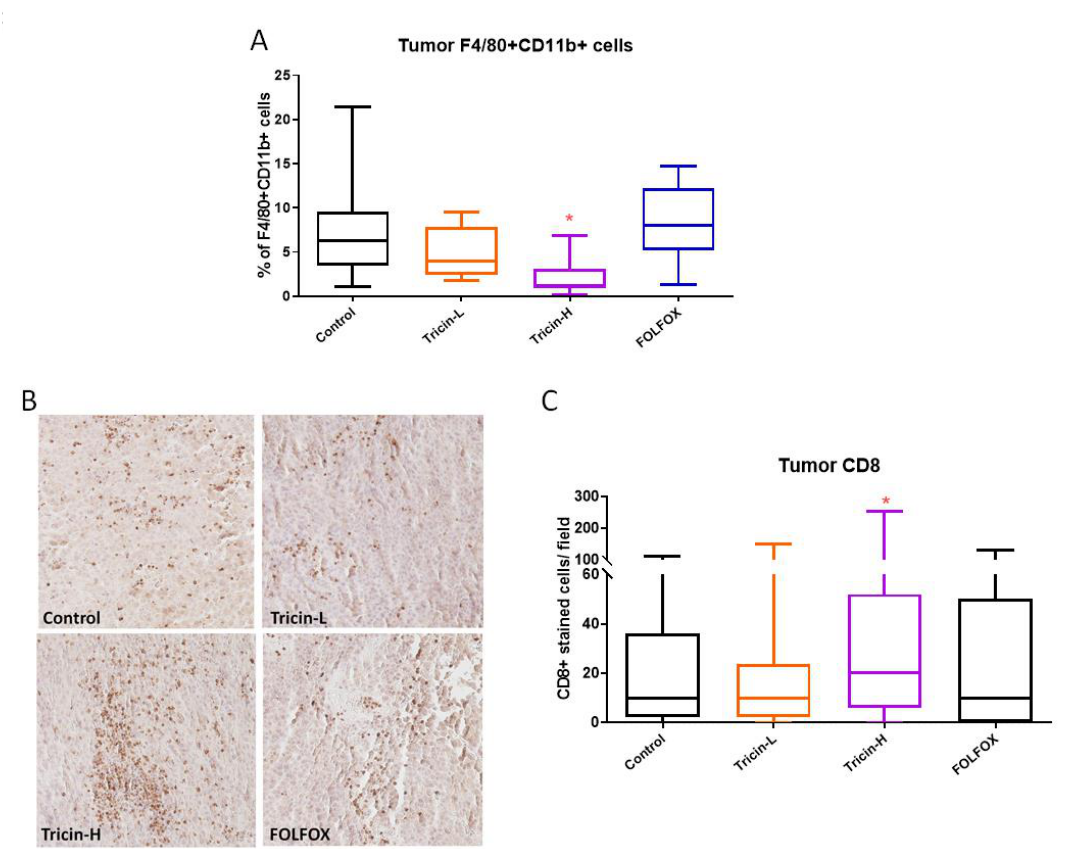
Figure 6. Effects of tricin and FOLFOX on immune cell populations in colon tumors. Tumors were collected from different groups and divided into two halves. Cells isolated from half piece of tumor were stained with anti-F4/80 and anti-CD11b antibodies and analysed by flow cytometry for determination of macrophage population. ( A ) Graph showed the percentage of F4/80 + CD11b + stained cells. Another half piece of tumor were embedded in paraffin and the tumor sections were stained with anti-CD8 antibody. ( B ) Representative photos showed CD8 + stained cells in dark brown color in the tumor sections. ( C ) Graph showed the number of CD8 + stained cells in each field. Results were expressed as box and whisker plots, n = 7–13. Differences among treatment groups were determined by one-way ANOVA followed by Tukey’s multiple comparisons test, * p < 0.05 as compared with control group.